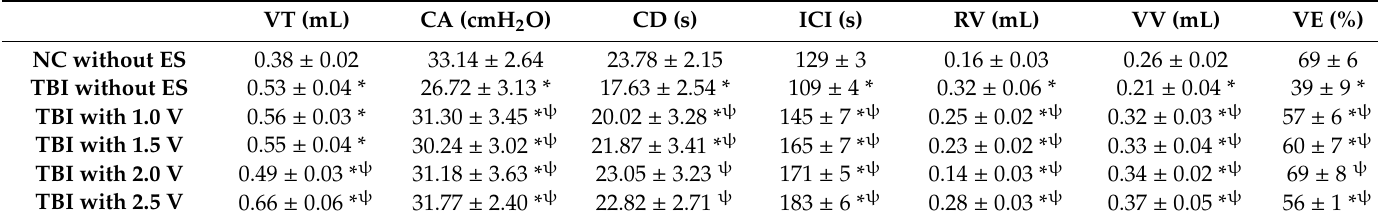
Table 1. Cystometric measurements of normal control (NC), traumatic brain injury (TBI), and TBI rats treated with pedunculopontine tegmental nucleus (PPTg)-deep brain stimulation (DBS) at di ff erential voltages of electrical stimulation